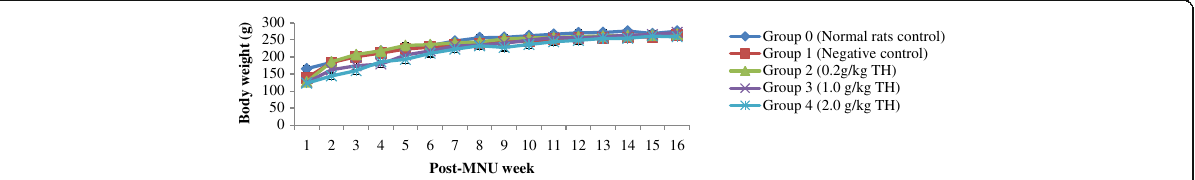
Fig. 2 Body weight (g) progression over time (in weeks) after MNU induction. Data is presented as mean ± SEM. A mixed model two-way repeated measures ANOVA was conducted. A significant positive body weight progression was observed over time, ( p <0.05). Legends: TH = Tualang honey, MNU = 1-methyl-1-nitrosourea, Negative control = Group that received tumor induction but no honey